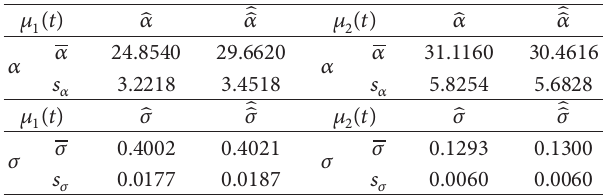
Table 3: Results of RMS error for each estimation 𝜇 1 (𝑡) and 𝜇 2 (𝑡) . Table 4: Estimated and reestimated parameters. The estimations are calculated with the convolution (𝑐 hp 𝑘 ) . Results obtained with 1000 RMS Case 1 Case 2 simulations with 250 observations each for 𝜇 1 and 𝜇 2 as defined in 𝑐 1 0.0782 0.0266 Table 1: case 1 𝛼 = 30 and 𝜎 = 0.4 , case 2 𝛼 = 30 and 𝜎 = 0.13 . 𝑘